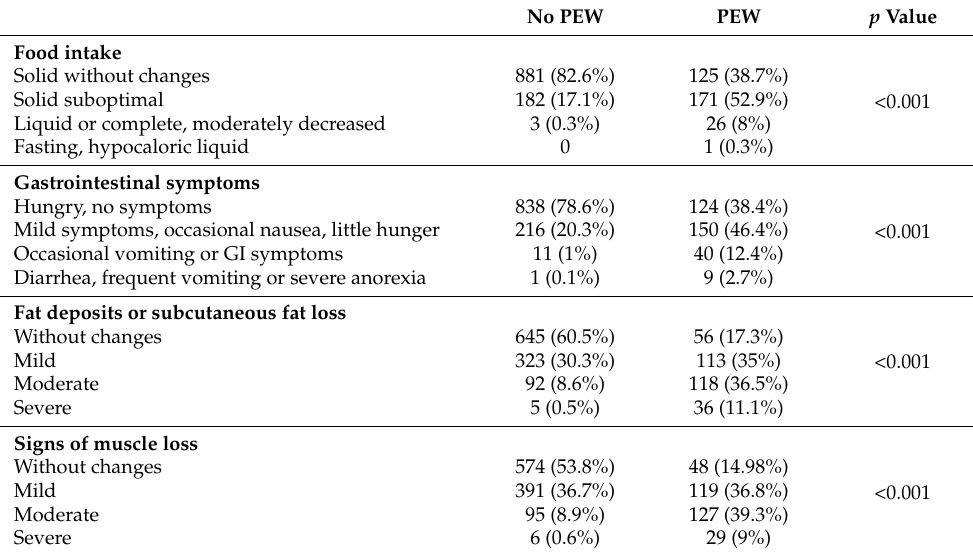
Table 2. Clinic parameters of nutrition.